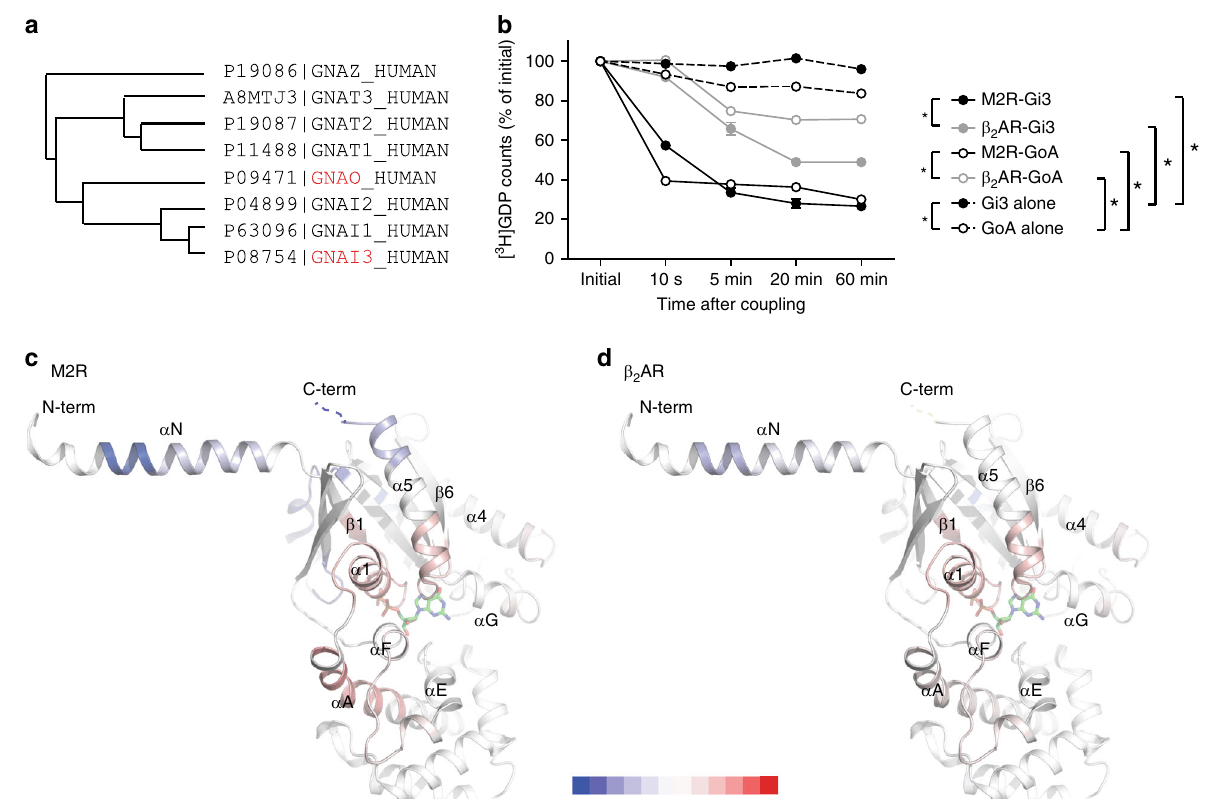
Fig. 1 GDP release and HDX-MS analysis of different GPCR-G protein pairs. a Phylogenic tree of G α i/o families. The phylogenic tree is generated based on the protein sequences provided by UNIPROT database (uniprot.org). The uniprot ID is indicated in front of the protein names. b GDP release pro fi les of GoA and Gi3, induced by the M2R or the β 2 AR. * Indicates statistical differences between groups analyzed by one-way ANOVA test ( p < 0.05). Error bars represent mean ± S.E.M. of three independent experiments. Source data are provided as a Source data fi le. c , d HDX level changes of G α oA after 3 h of incubation with the M2R ( c ) or the β 2 AR ( d ). The changes in HDX are color-coded on the X-ray crystal structure of G α i1 (PDB 1GP2). The deuterium uptake plots are provided in Supplementary Fig.